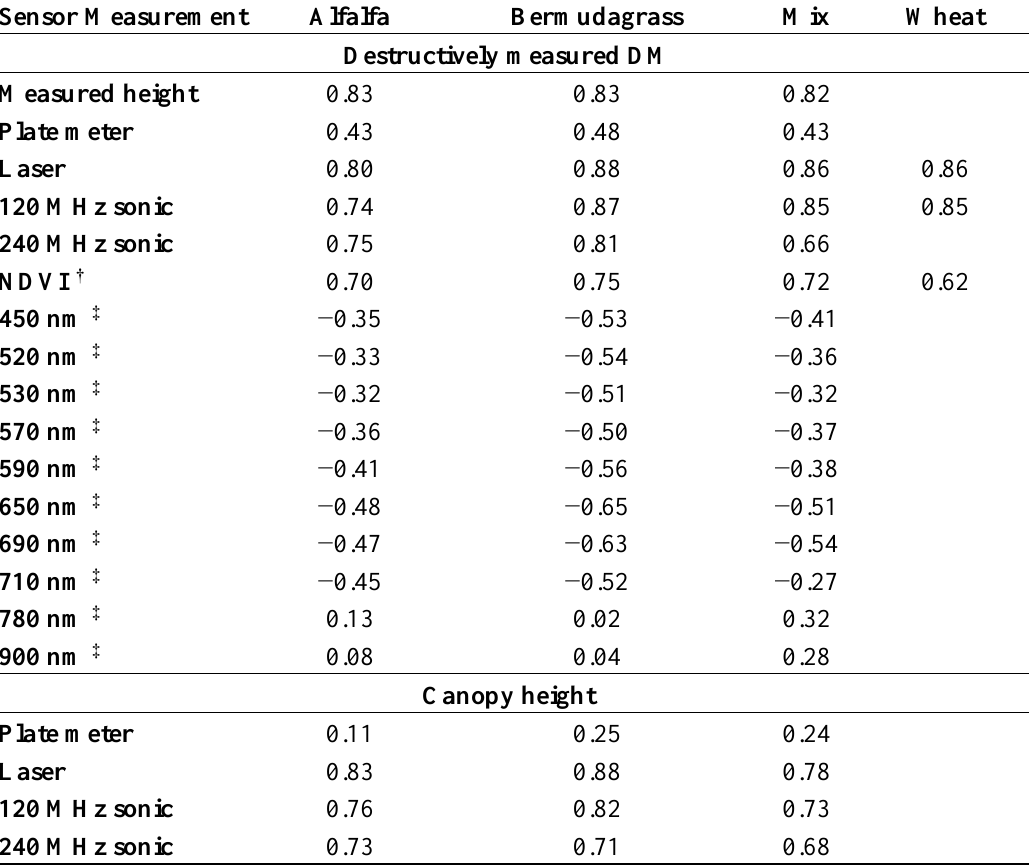
Table 3. Pearson coefficients for sensor collected parameters correlated to physical measures. † From Greenseeker ® , ‡ From